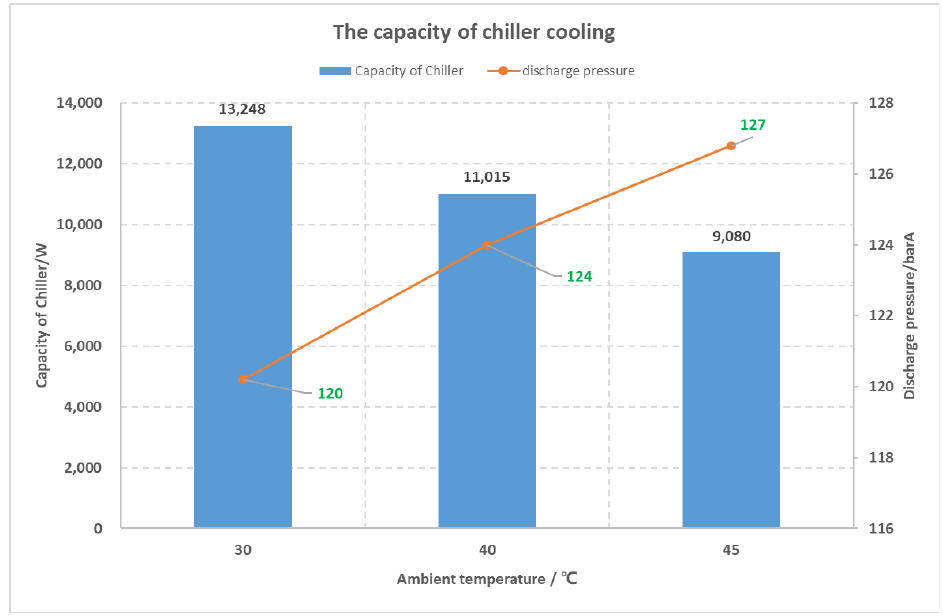
Figure 6. The capacity of chiller cooling with ambient temperatures of 30 °C, 40 °C, and 45 °C.